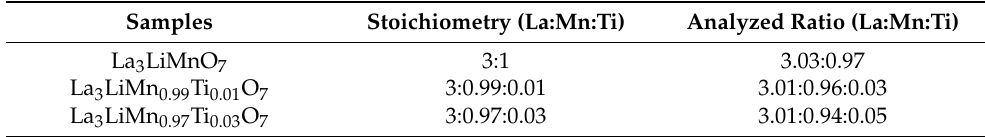
Figure 3. SEM images of ( a ) La 3 LiMnO 7 and ( b ) La 3 LiMn 0.97 Ti 0.03 O 7 . Table 2. Elemental ratios of La, Mn, and Ti for the La 3 LiMn 1− x Ti x O 7 (0 ≤ x ≤ 0.03) samples. Table 2. Elemental ratios of La, Mn, and Ti for the La 3 LiMn 1 − x Ti x O 7 (0 ≤ x ≤ 0.03) samples. Samples